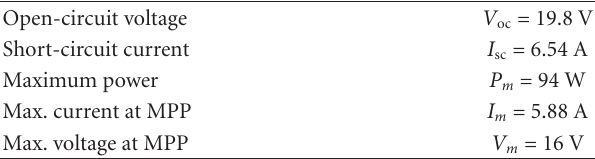
Table 2: Electrical characteristics of the Isofoton I-94/12